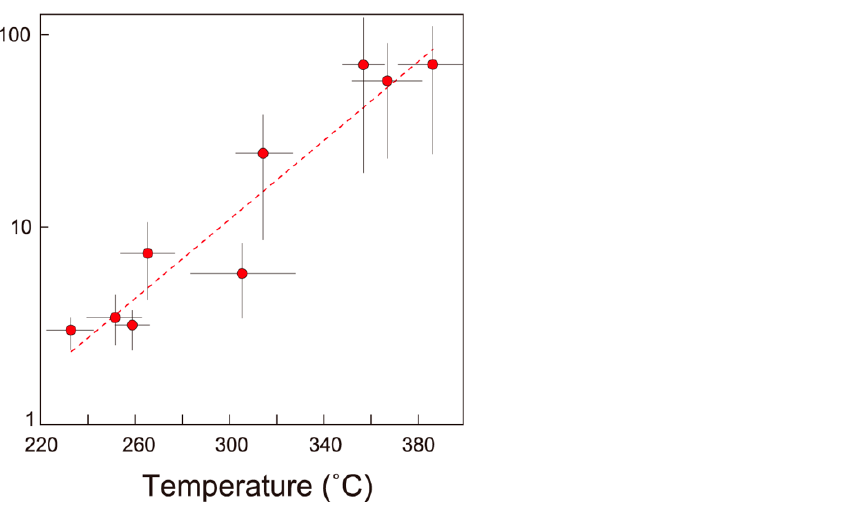
Figure 9. Relationship between the RSCM temperature estimates and the RMS data for samples from adjacent localities.